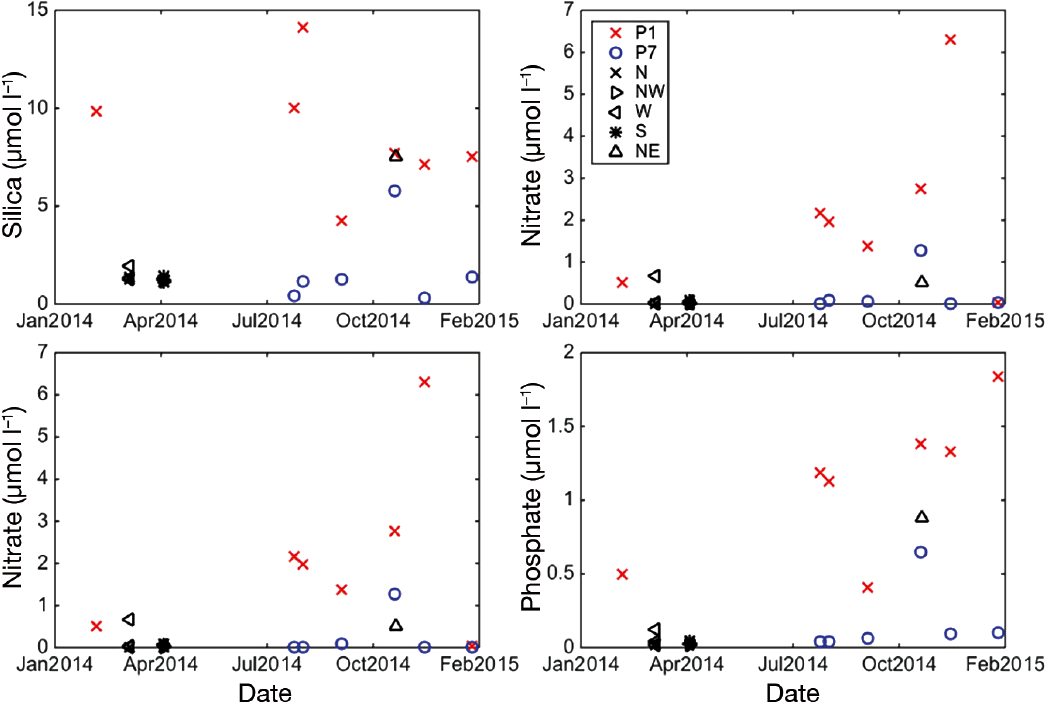
Fig. 8. Surface nutrient concentrations of silica, nitrate, nitrite, and phosphate measured over the sampled months at Stns P1 (red) and P7 (blue), and at Stns N, NW, W, S, and NE on Shi’b Habil